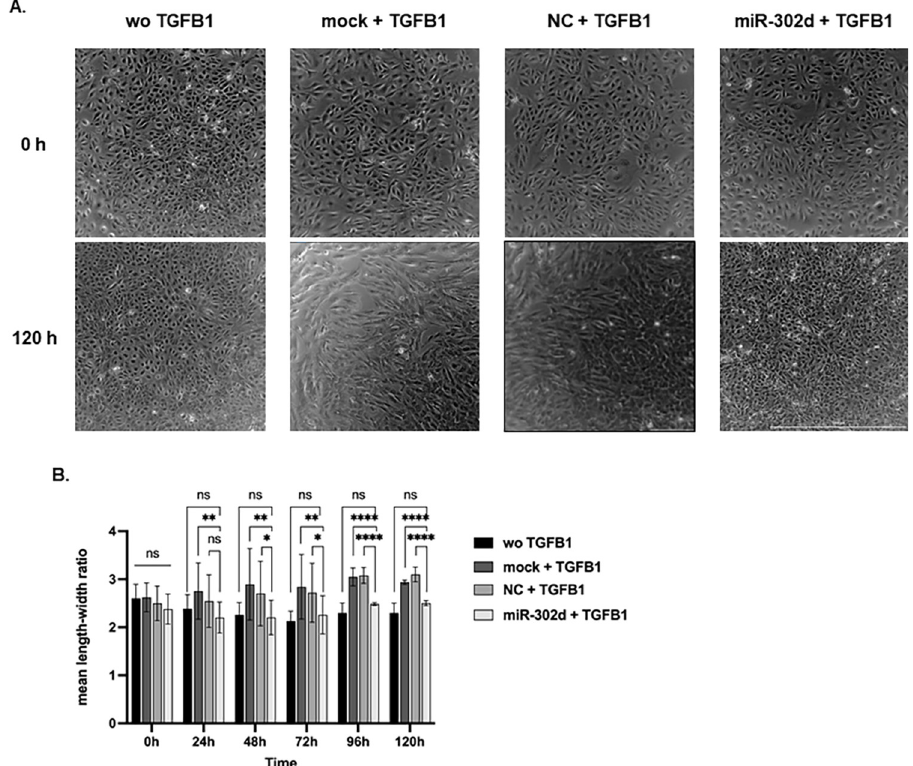
Fig 2. miR-302d inhibits TGFB-induced fibroblastic morphological changes in hRPE cells. hRPE cells were supplemented with or without TGFB1 for 5 d 24 h after transfection with mock, NC, or miR-302d. (A) The morphology of transfected hRPE cells at the beginning of TGFB1 exposure and 5 d later (S1 Video). The scale bar represents 1000 μ m. (B) Mean length-width ratio changes of hRPE cells after TGFB1 exposure. Unpaired two-tailed t- tests (n = 3) were performed. The error bars represent SD. ns, non-significant, � p < 0.05, �� p < 0.01, ���� p <